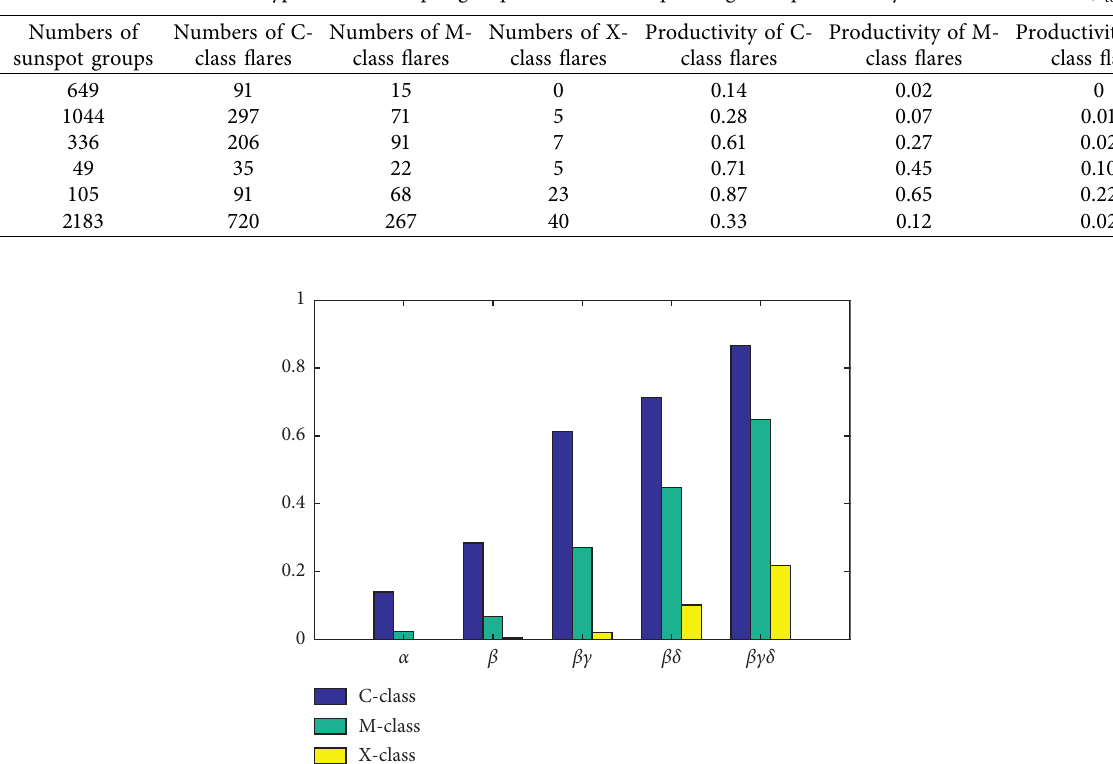
Figure 6: Productivity of C-class, M-class, and X-class flares of various types of the sunspot groups from January 2011 to April 2020 ≥ ( I tot